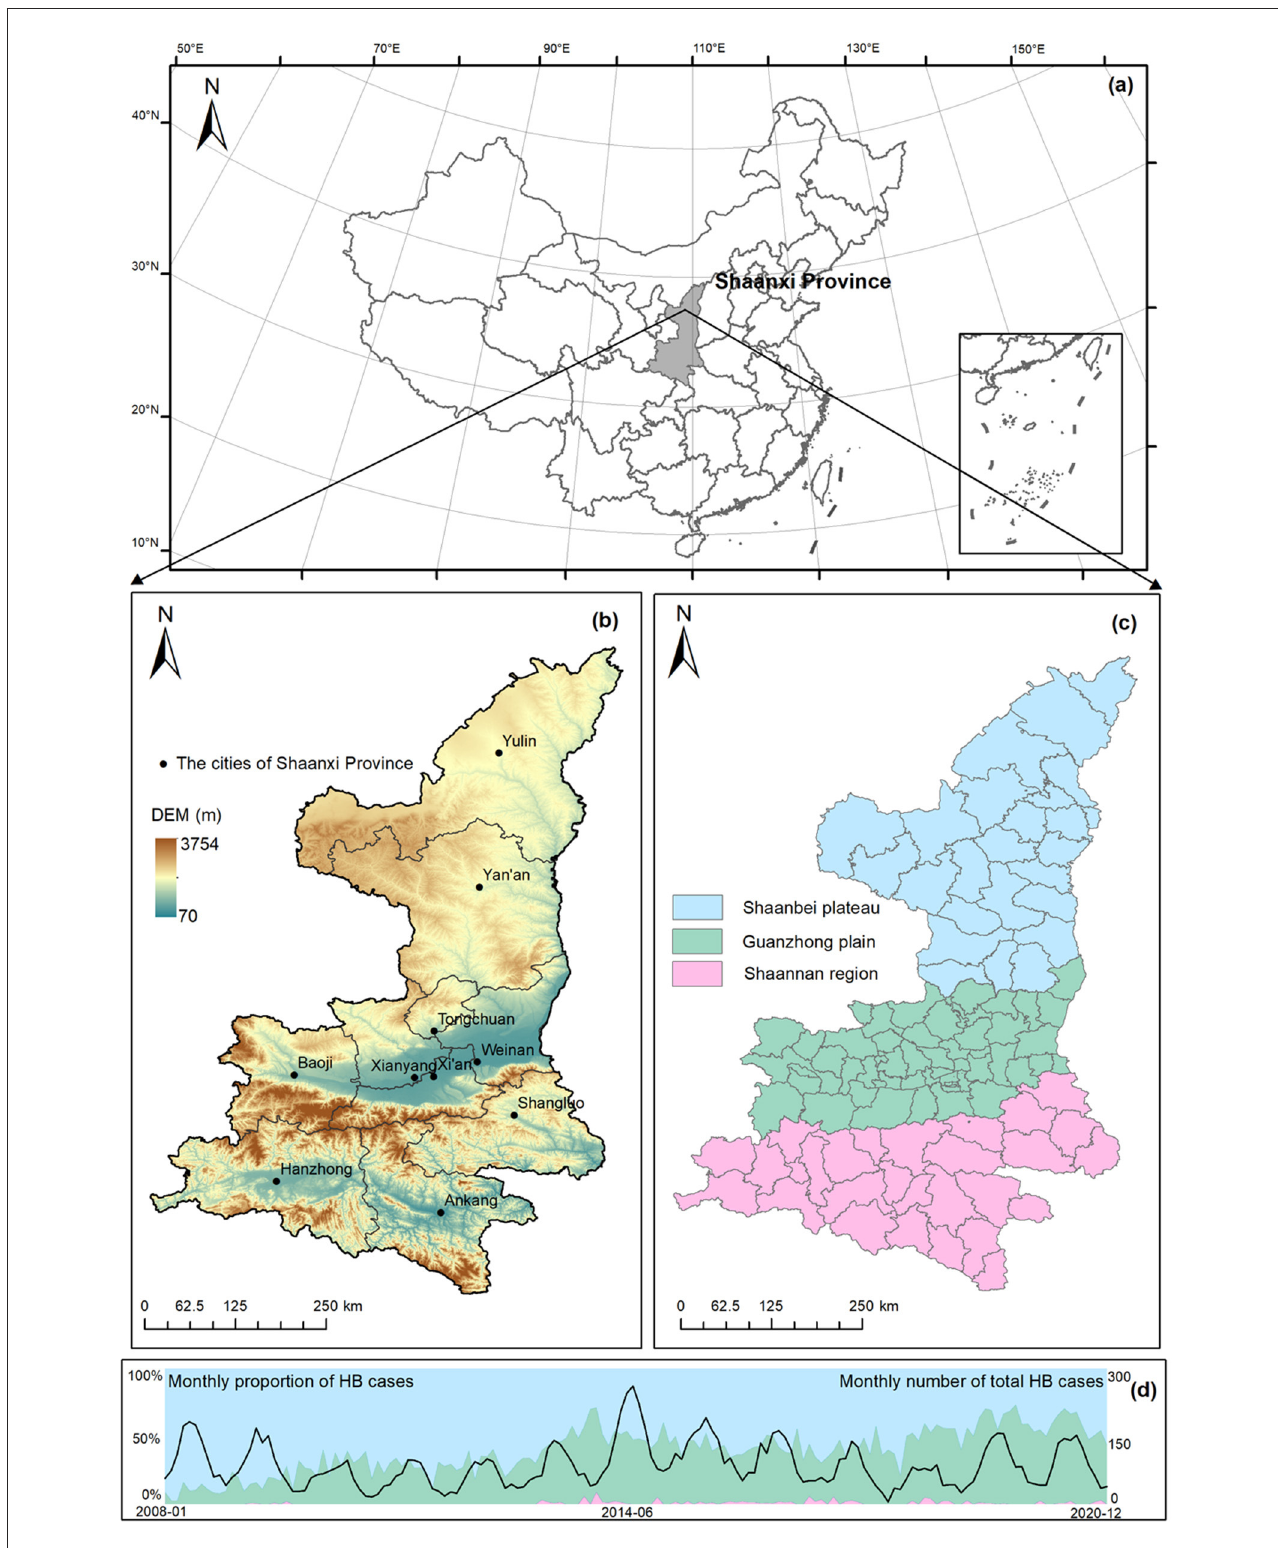
FIGURE2 Study area and dynamic changes in HB cases. (a) Geographical location, (b) landforms and cities, (c) regional division, and (d) monthly number of HB cases in Shaanxi Province.